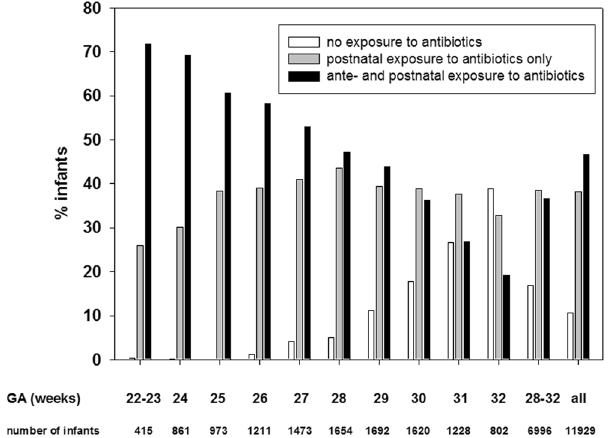
Figure 1. Exposure to antenatal and postnatal antibiotics according to gestational age. The figure describes the percentage of infants exposed to antenatal and/or postnatal antibiotics. A small percentage of infants was exposed to antenatal antibiotics but not to postnatal antibiotics (22–23 weeks: 1.4%, 24 weeks: 0.5%, 25 weeks: 0.8%; 26 weeks: 1.4%, 27 weeks: 2.0%; 28 weeks: 4.1%, 29 weeks: 5.6%; 30 weeks: 7.3%, 31 weeks: 9.4%; 32 weeks: 9.2%, 28–32 weeks: 6.6%; all: